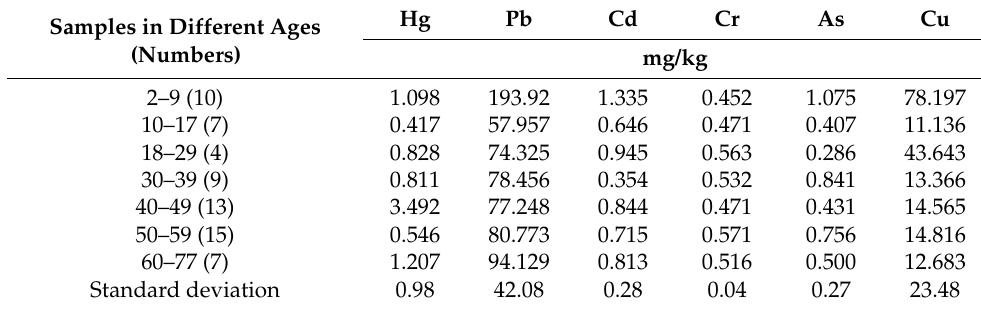
Table 2. The average contents of toxic trace elements in human hair of different ages in the polluted